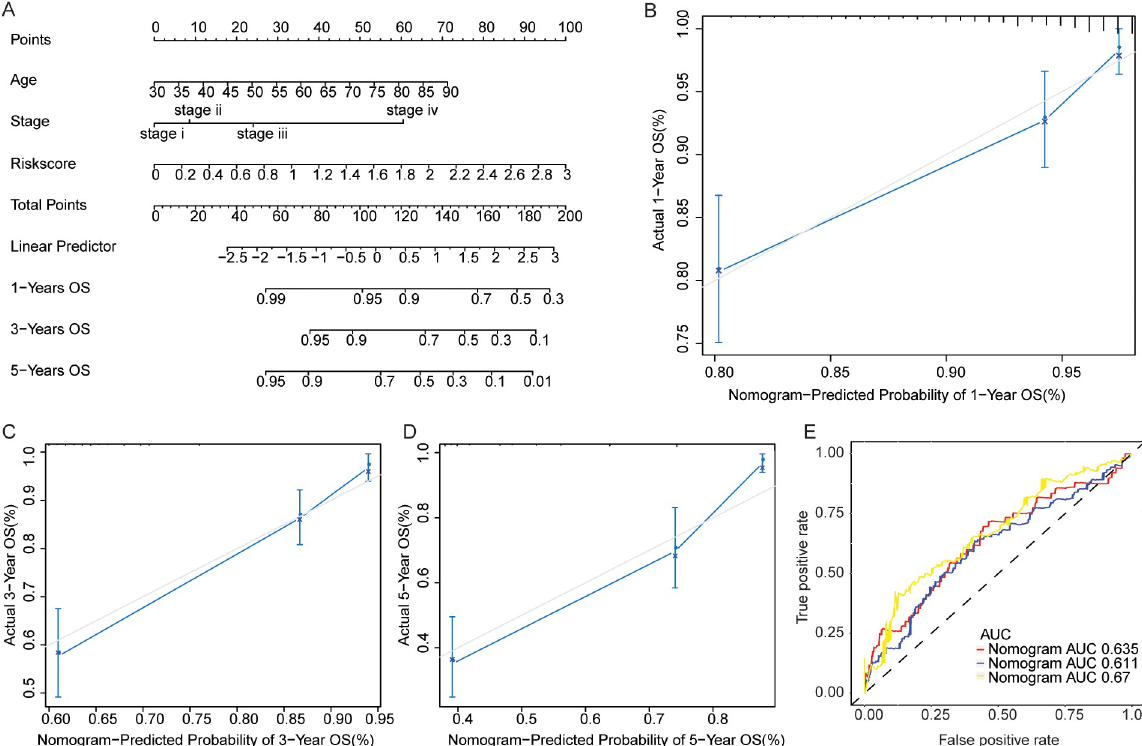
Fig 3. Nomogram for CRC survival outcome estimation. (A) Nomogram that combined TNM stage and risk score. A single point is assigned to the stage or risk score that is perpendicular to the points line. Total point is assigned to every CRC sample by combining the sample’s risk score and TNM stage corresponded point. The OS at 1, 3 and 5 years was estimated according to the corresponding total point. (B-D) Calibration curve for the nomogram which estimated the OS at 1, 3, and 5 years respectively. (E) Time-dependent ROC curve of the samples. The horizontal axis was the false positive rate, and the vertical axis was the true positive rate. The predictive accuracy was evaluated by AUC.